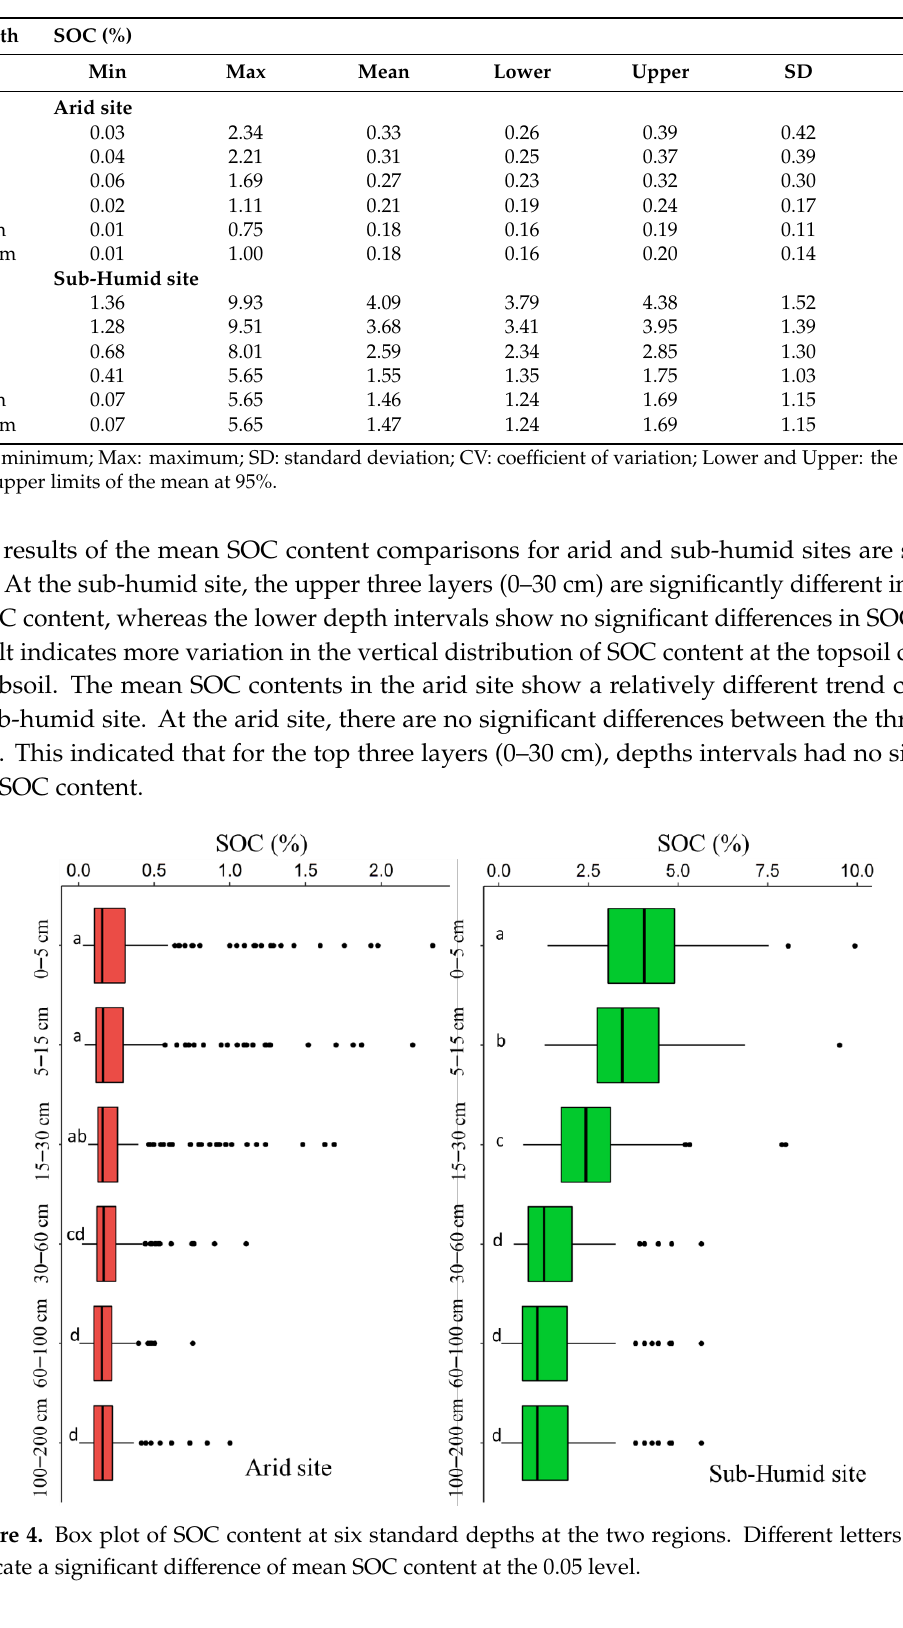
Table 4. Descriptive statistics of soil organic carbon (SOC) content at six standard depths in two regions.